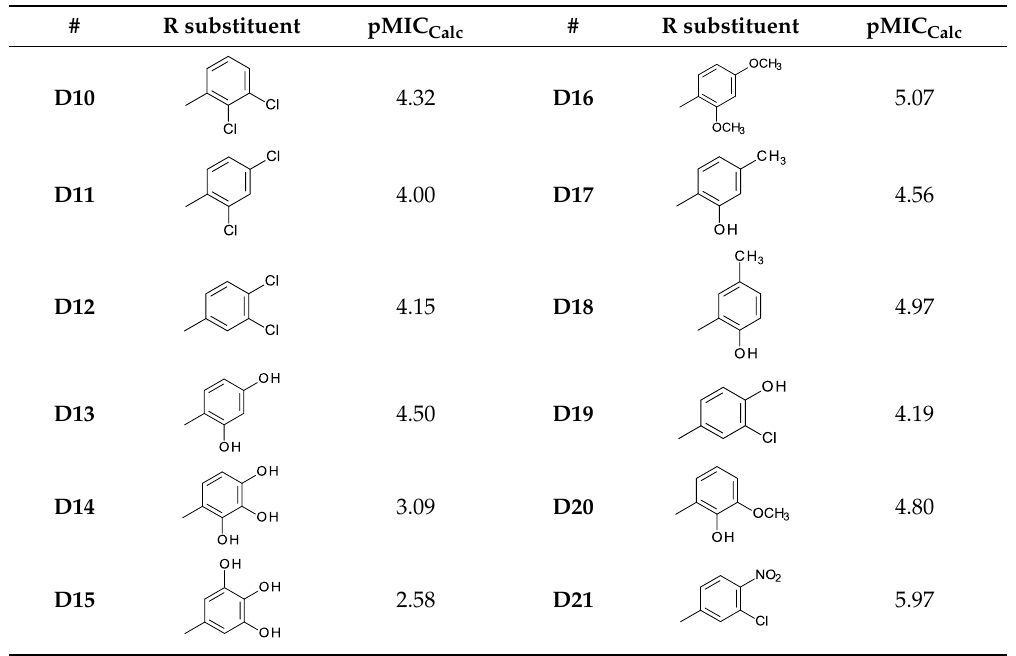
Table 7. Calculated pMIC (pMIC Calc ) values for D10 – D21 of tautomers II (R substituent) using the A/C (atoms and connections) HQSAR model.